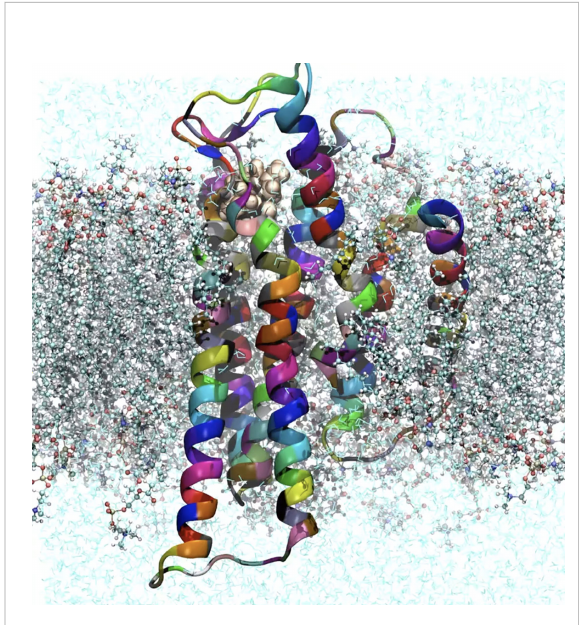
FIGURE 7 Predicted GCR1 3D atomic structure and composition embedded in a bi-lipid cell membrane and in explicit water. The structure was obtained from the primary of Arabidopsis Thaliana using a hybrid approach based on homology and our fi rst- principles methods (Hernandez et al.